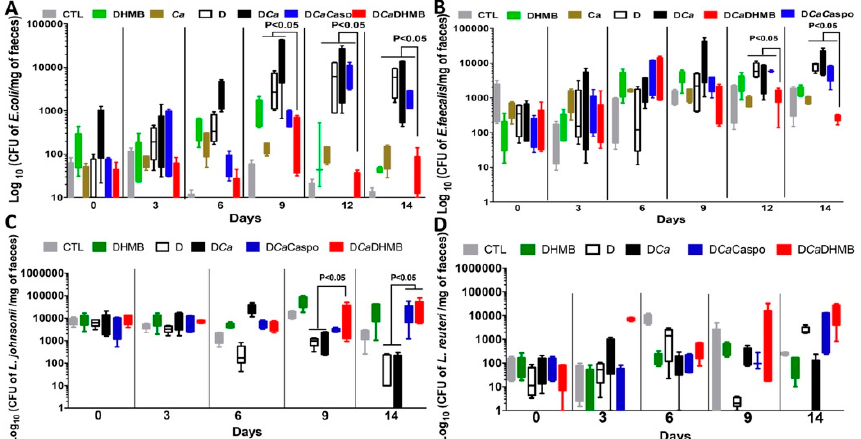
Figure 7. Determination of viable faecal aerobic and anaerobic bacteria in mice with colitis treated with DHMB. For all experiments, stool bacteria were collected from mice on Day 0 before C. albicans challenge and DSS treatment. ( A – D ) Number of E. coli , E. faecalis , L. johnsonii and L. reuteri colonies recovered from stools. Data are the mean ± SD of 10 mice per group from two independent experiments.